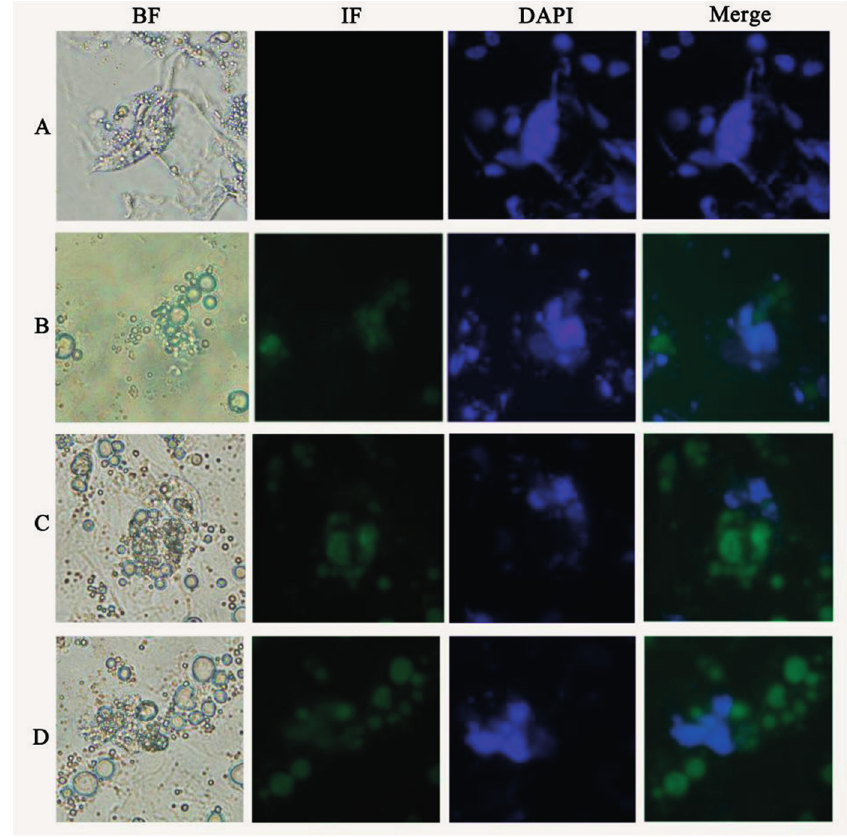
Figure 3. DAZL mRNA expression under ATRA, Am80, and E 2 induction compared with control chicken ESCs. The results are presented as a mean ± SEM of three duplicate runs. Error bars in charts represent the corresponding standard deviations.